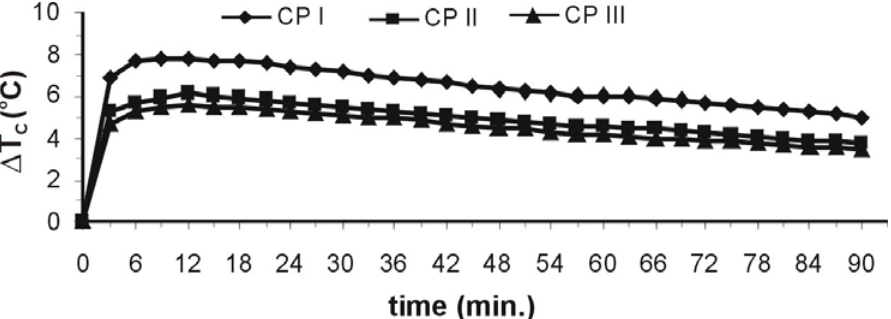
Figure 4. The variation of the temperature at the inlet and outlet of the condenser along the experiment according to the circulation pump flow rates at fixed waste water temperature of 40